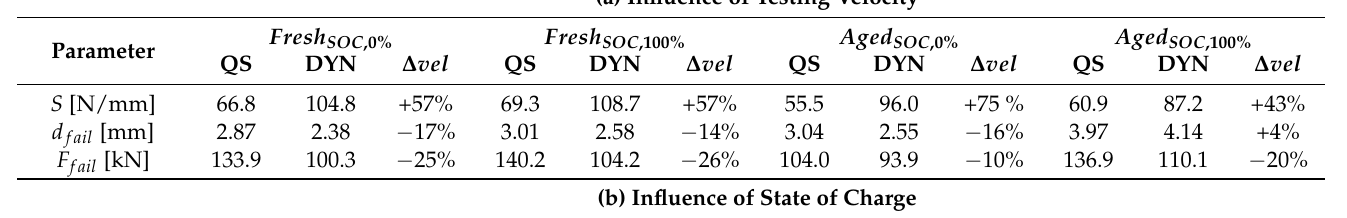
(b) Influence of State of Charge